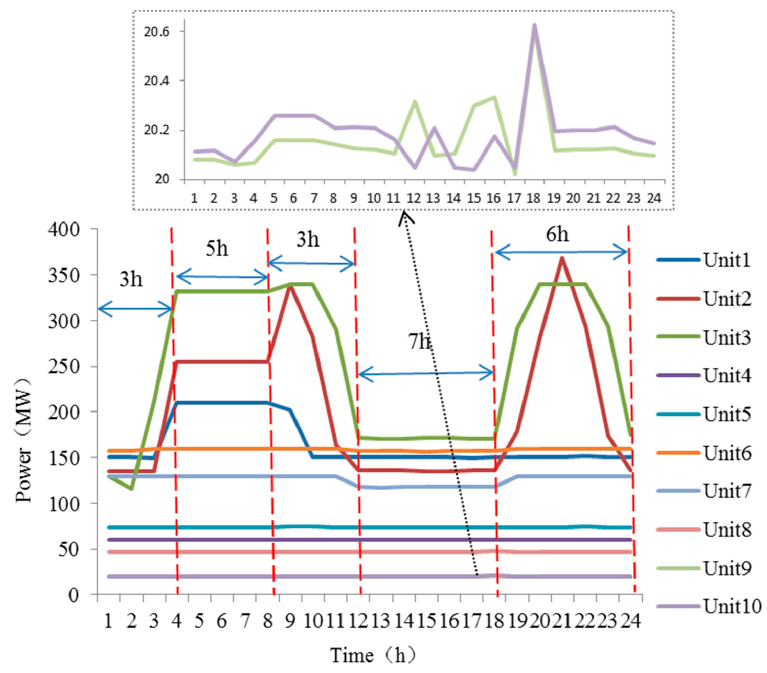
Figure 14. Power output curves of thermal generators in Case 2.